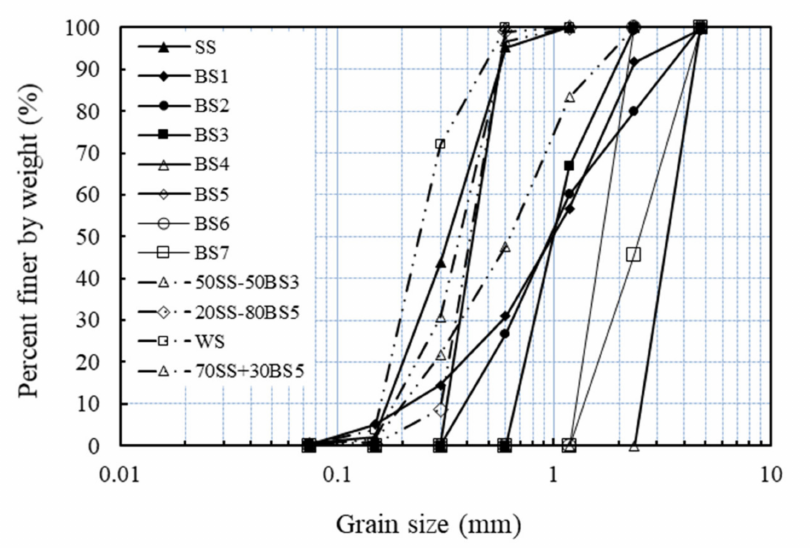
Figure 1. Particle size distribution curves of tested